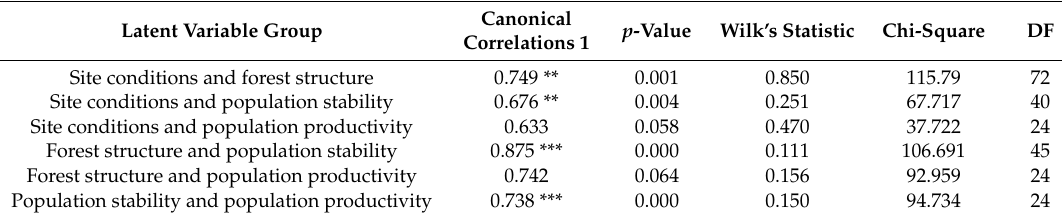
Table 4. Canonical correlation analysis